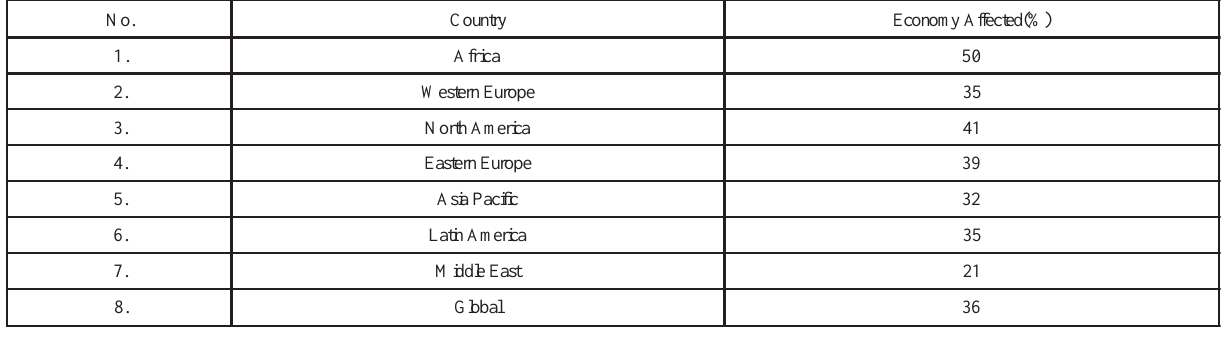
FIG. 3. ECONOMIC CRIMES 2016 AND TABLE 1. ECONOMIC CRIME REPORT 2016 & 2017